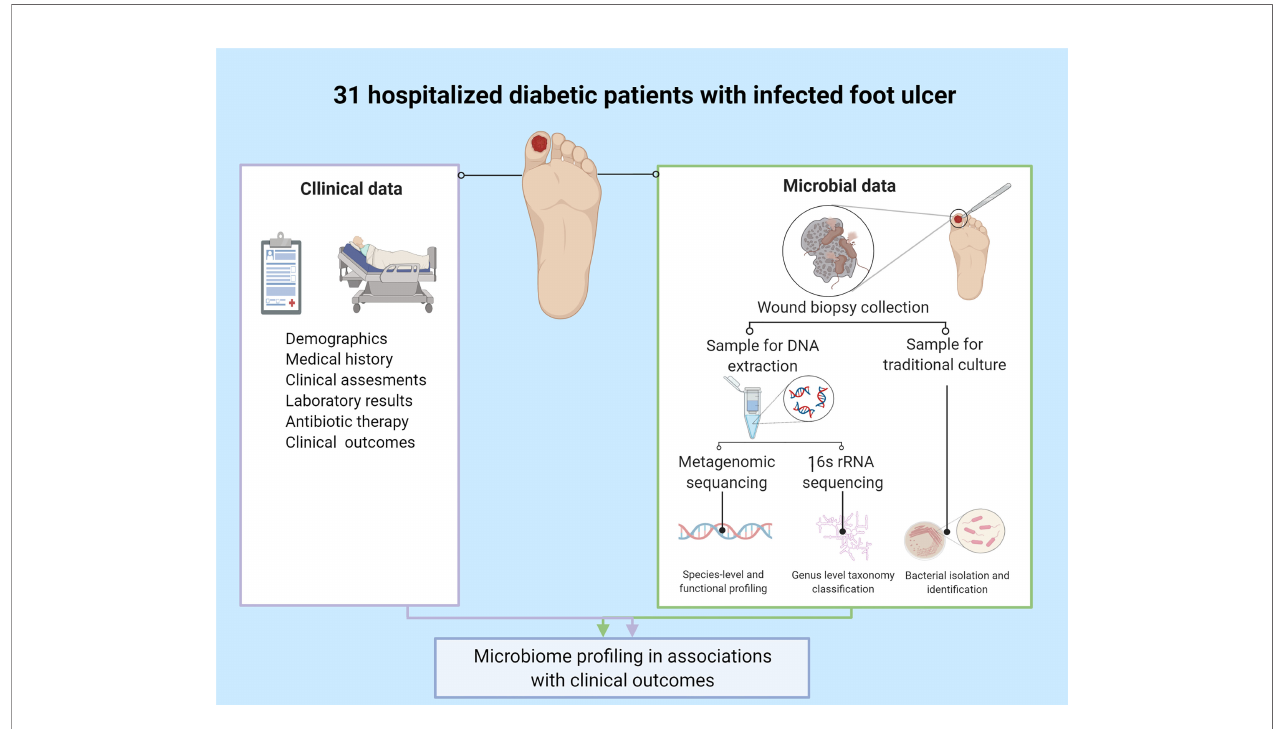
FIGURE 1 | Study design. Created with